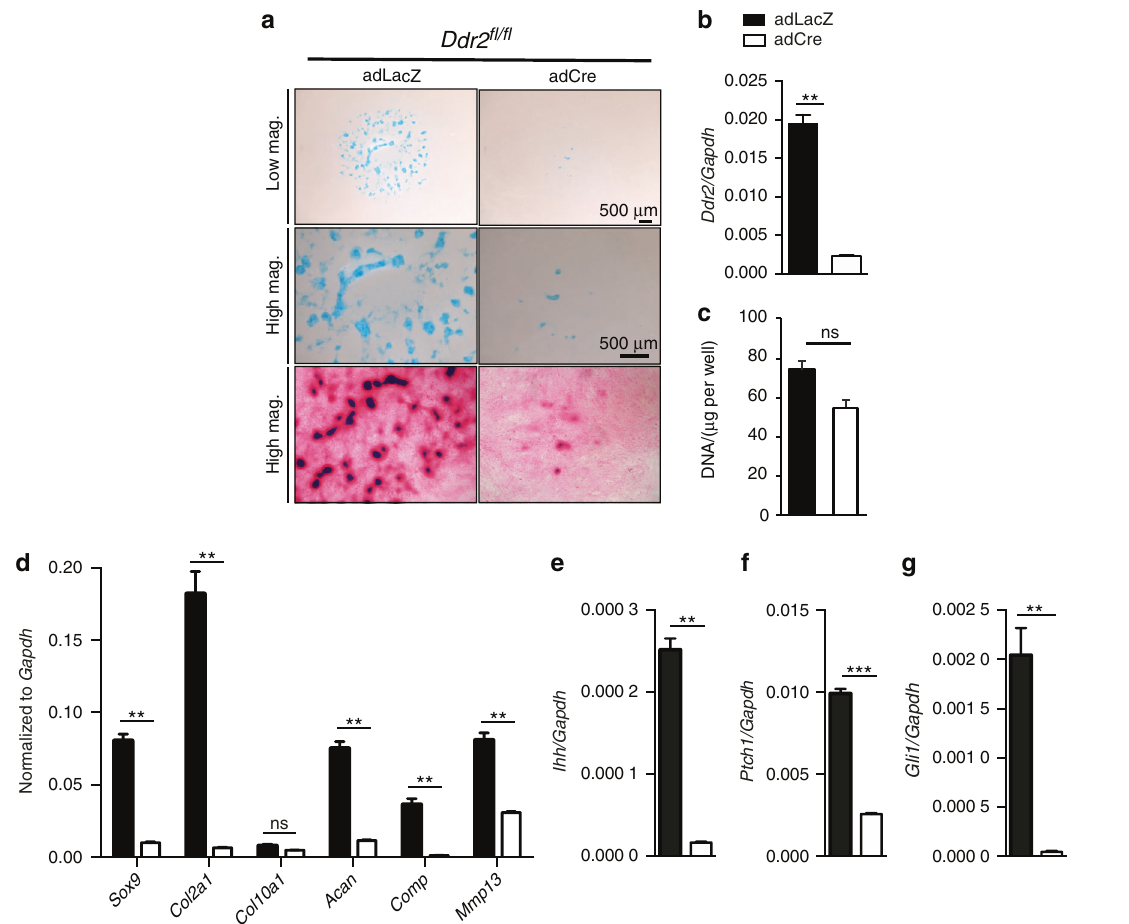
Fig. 8 Ddr2 de fi ciency inhibits chondrogenic differentiation in micromass cultures. a Chondroprogenitor cells isolated from limb buds of E12.5 Ddr2 fl / fl mice were treated with AdLacz or AdCre and differentiated for 8 days followed by alcian blue staining (top two panels) or were subsequently stained with eosin (bottom panel). Scale bar: 500 μ m. b Total DNA. b, c – f Quantitative real-time RT-PCR (qRT-PCR) gene expression analyses of micromass cultures. b , c Ef fi cient knockdown of Ddr2 . c Gene expression analysis of chondrocyte differentiation markers. d – g Gene expression analysis shows downregulation of chondrocyte and hedgehog signaling in Ddr2 -de fi cient chondrocytes. Unpaired t -test * P < 0.05, ** P < 0.01; *** P < 0.001; **** P < 0.000 1; ns Not signi fi